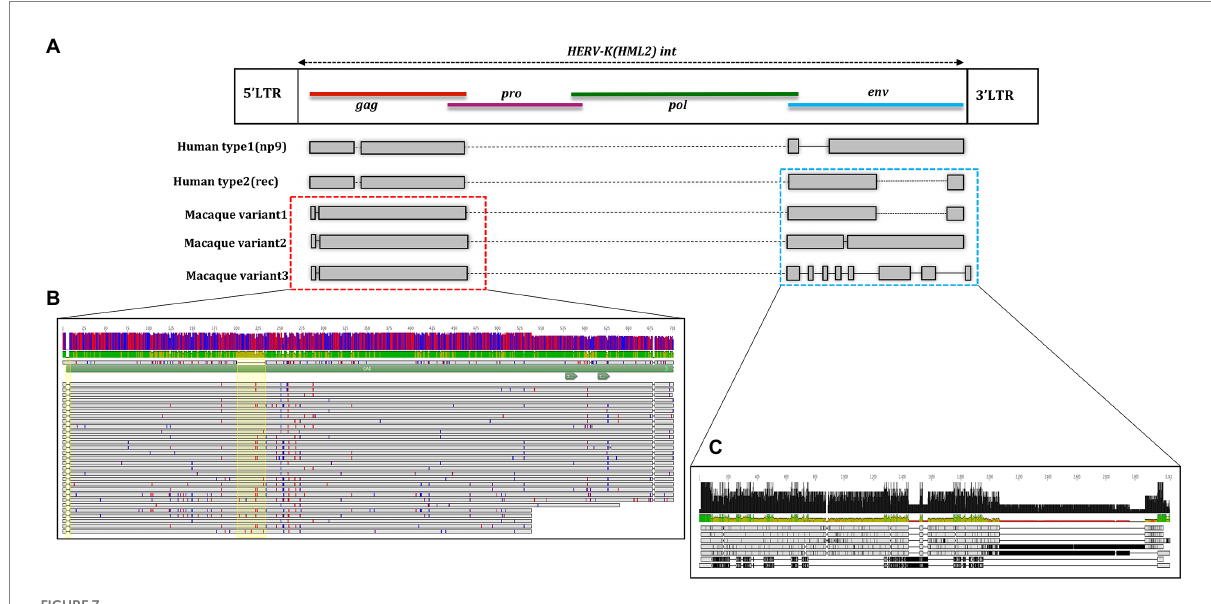
FIGURE 7 Structural representation of gag and env genes HML2 with respect to the consensus generated from potential residual ORFs of Human and Macaque species ( Macaca fascicularis and Macaca mulatta ). (A) The variants 1, 2, and 3 are specified based on the variation in the env region. The solid black lines refer to the deletion in the regions while the dotted lines are the stretch based on the insertions in that specific region. (B) Alignment of potential coding capacity of the gag genes of both the macaque species (described in detail in Table 3). Characteristics indels in macaque gag proteins as compared to human ones are highlighted with yellow blocks. (C) Alignment of the consensus generated for each cluster in both M. fascicularis (Macfas) and M. mulatta (Rhesus), the alignment of the three variants in both species are according to that indicates in (A)